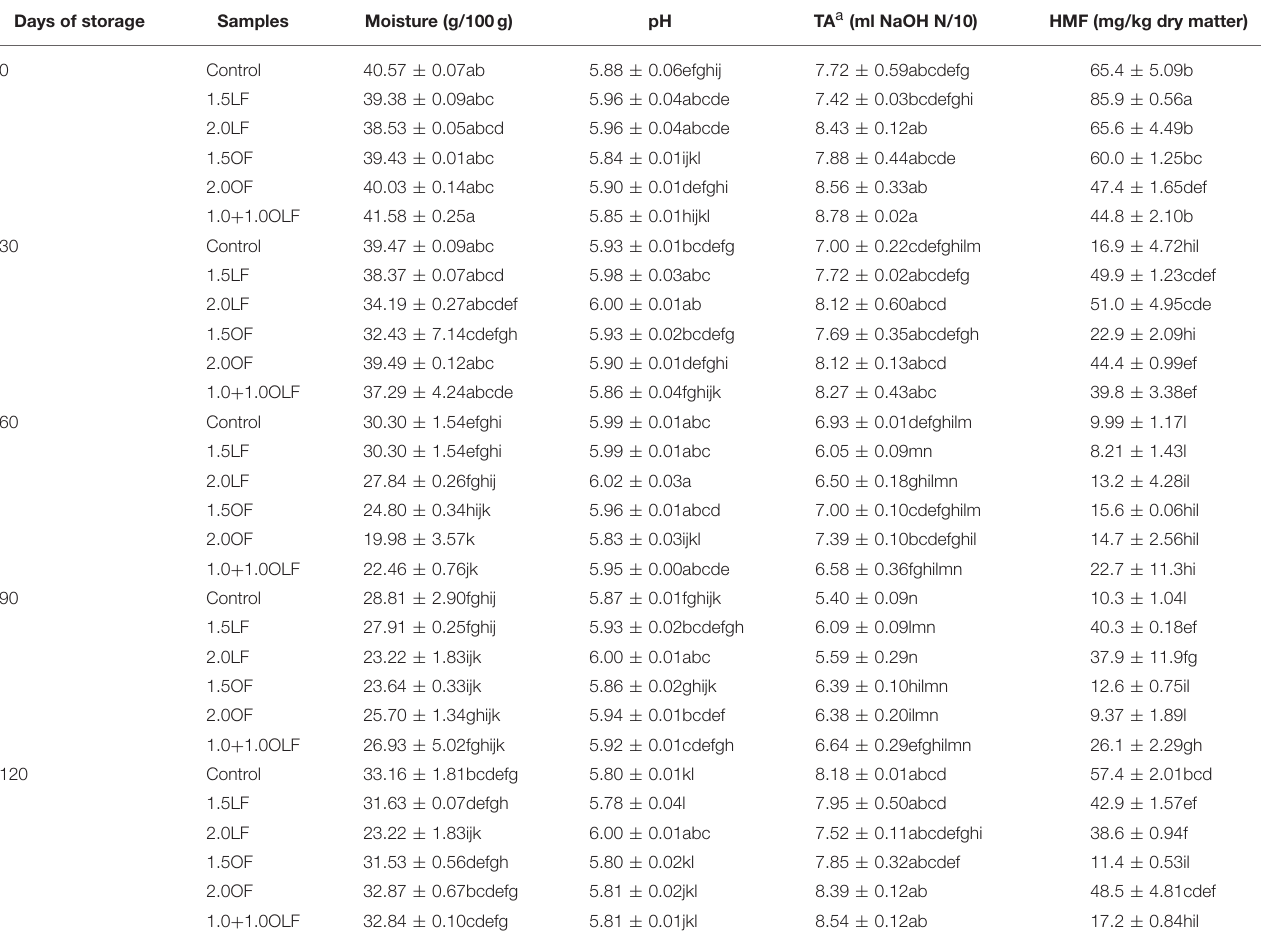
TABLE 6 | Evaluation of the chemical characteristics of the bread samples produced using different levels of citrus fiber during storage. Days of